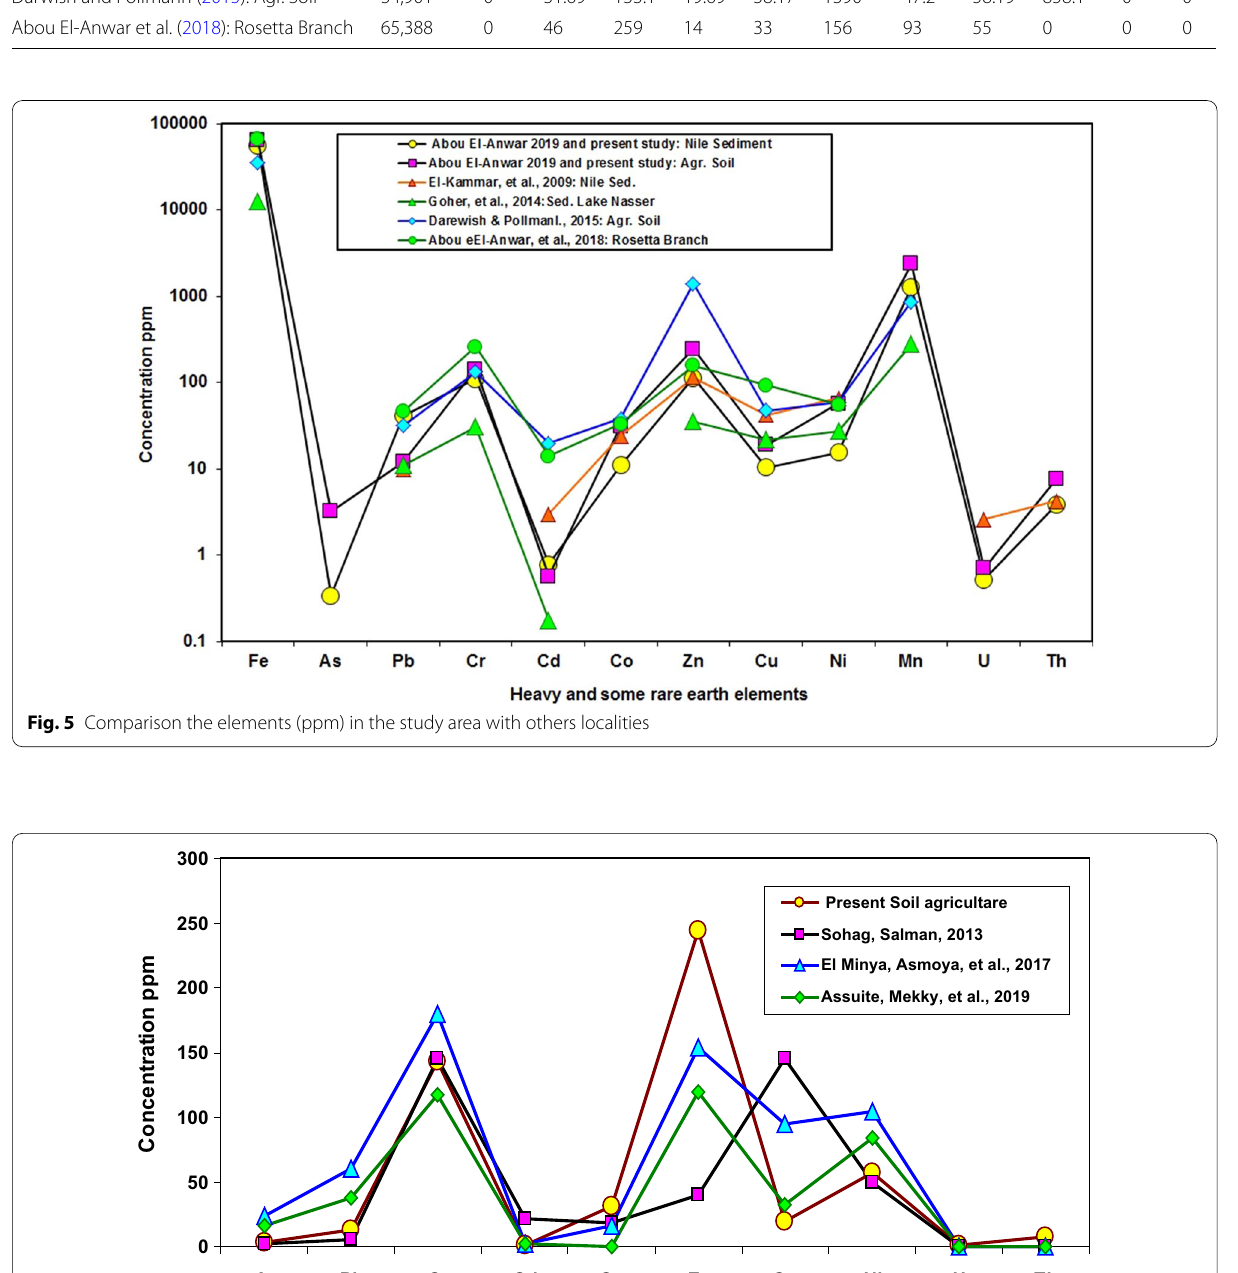
0 Fig. 6 Comparison the elements (ppm) in the study area with others localities in Upper